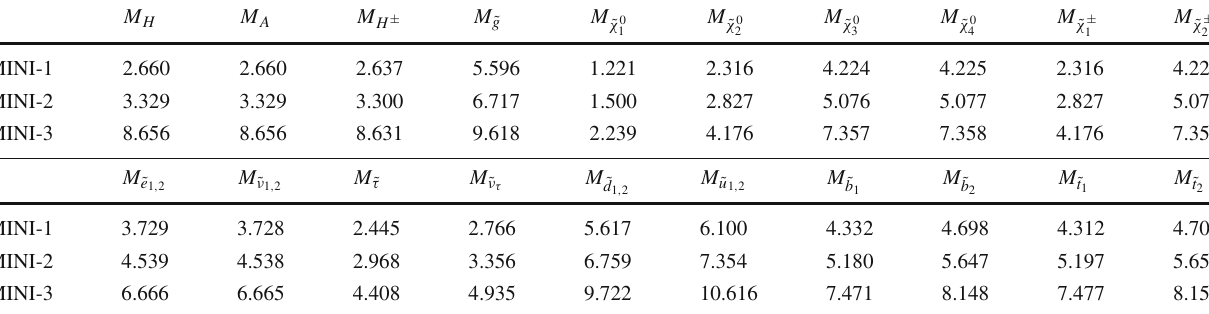
Table 2 Masses of Higgs bosons and some of the SUSY particles for each benchmark of the Minimal N = 1 SU ( 5 ) (in TeV)